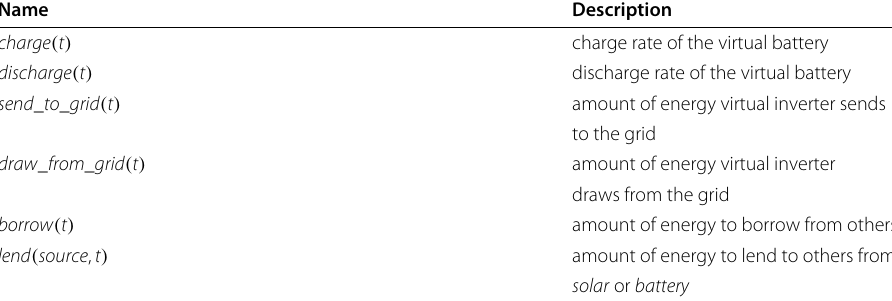
Table 1 Summary of the virtual abstraction API primitives AutoShare exposes to a virtual